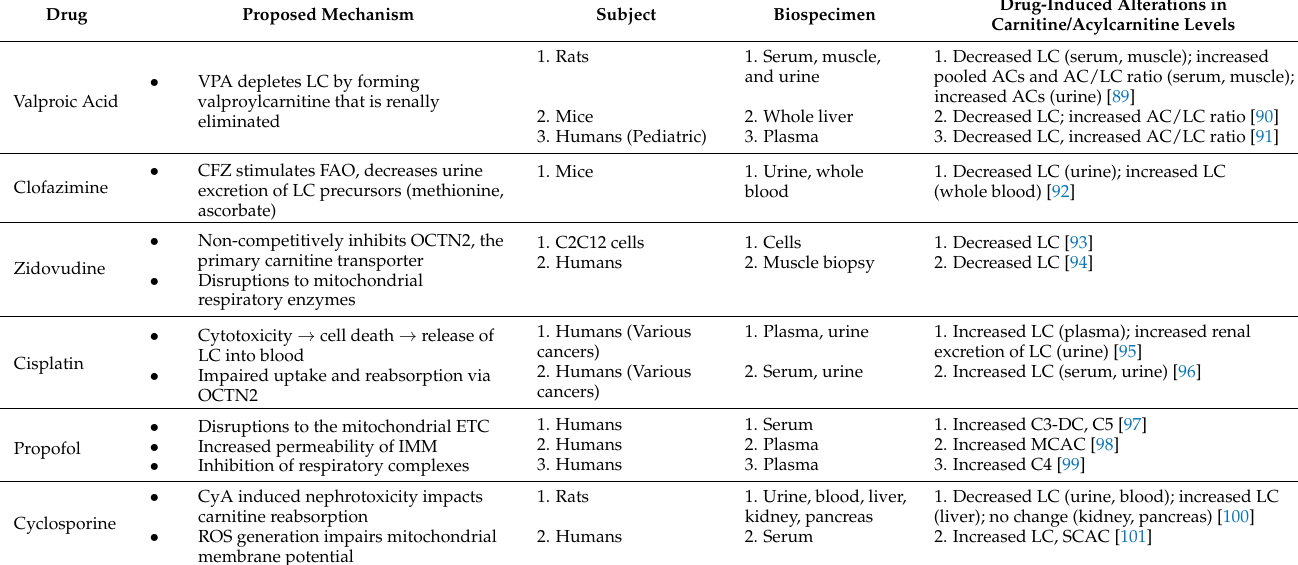
Table 3. Examples of drugs that influence carnitine and acylcarnitines levels in the